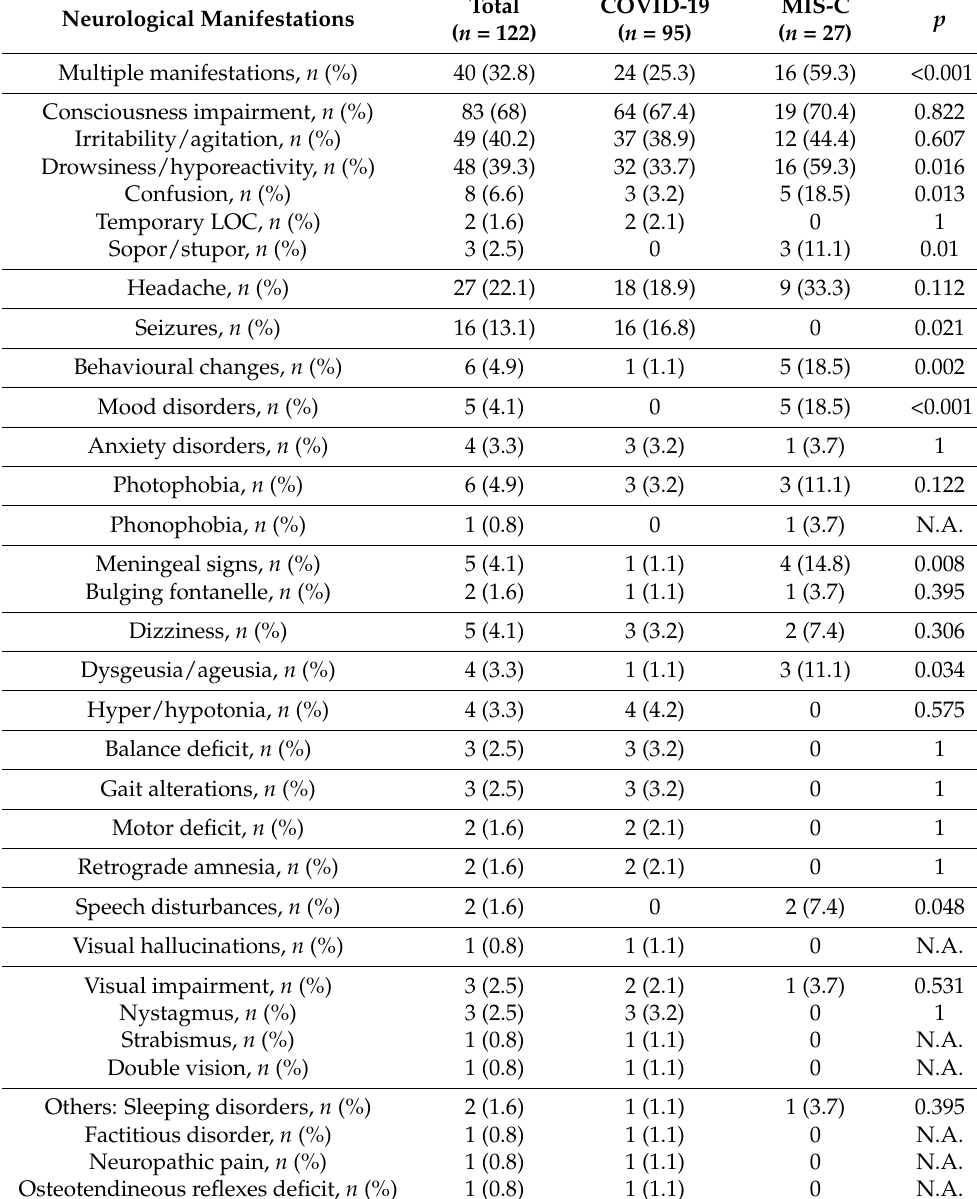
Table 2. Neurological manifestations in the whole disease